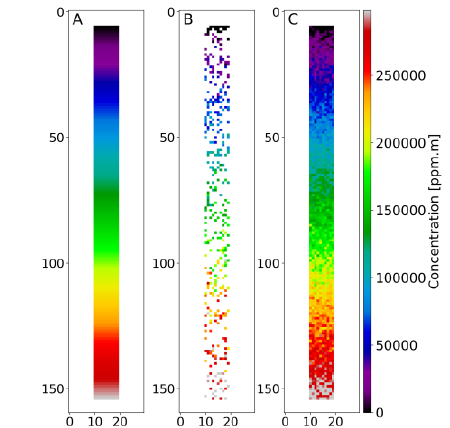
Figure 6 . Map concentration of plume in ppm.m. Panel A: synthetic concentration. Panel B: PTE concentration. Panel C: hybrid concentration.